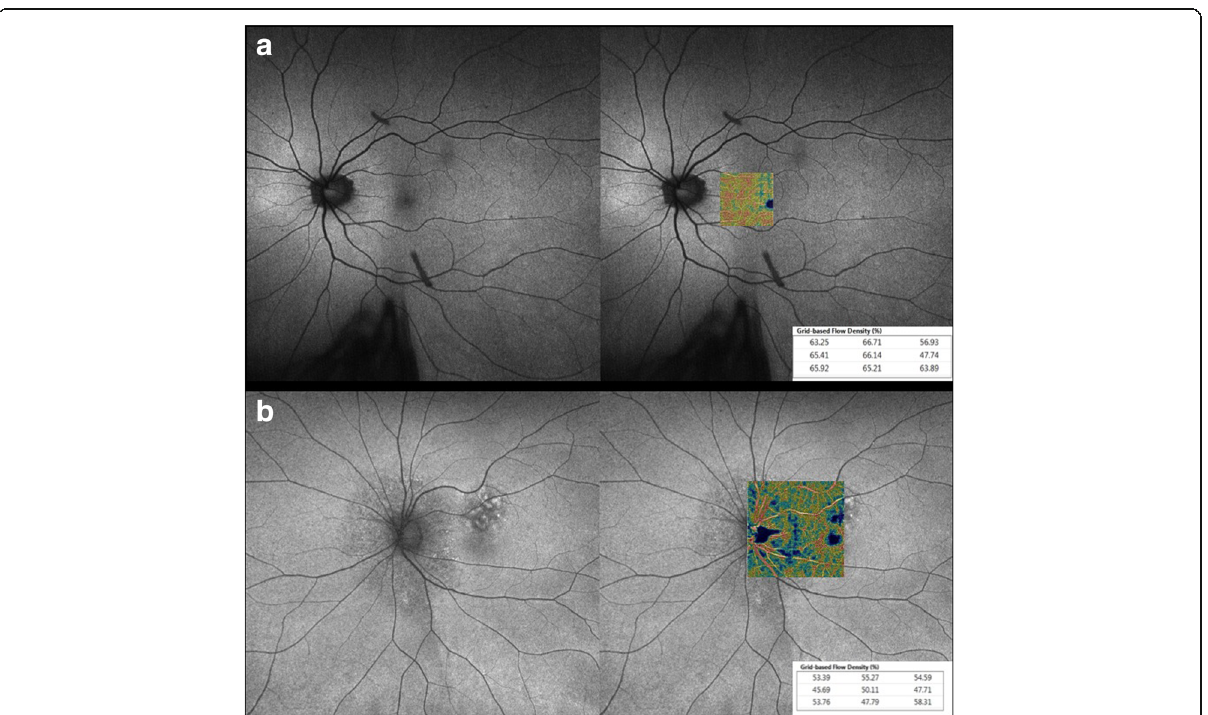
Fig. 7 Fundus autofluorescence of the left eye of a patient with active AZOOR ( a ) illustrates hyper-autofluorescence around the disc. The corresponding deep plexus OCT angiogram displays an increased flow corresponding to the active hyper-autofluorescent lesion. A second patient with AZOOR and no activity with fundus FAF ( b ). The color-coded map of the deep capillary plexus on OCTA is superimposed over the FAF image and does demonstrate re- duced deep capillary flow at the edge of the inactive AZOOR